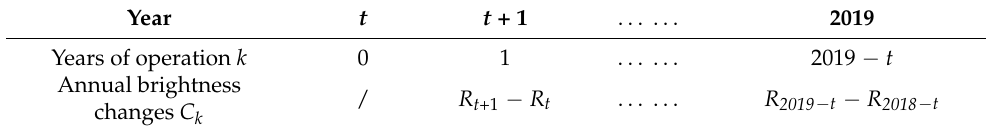
Table 1. Years of operation and annual brightness changes for stations starting HSR operation in year t